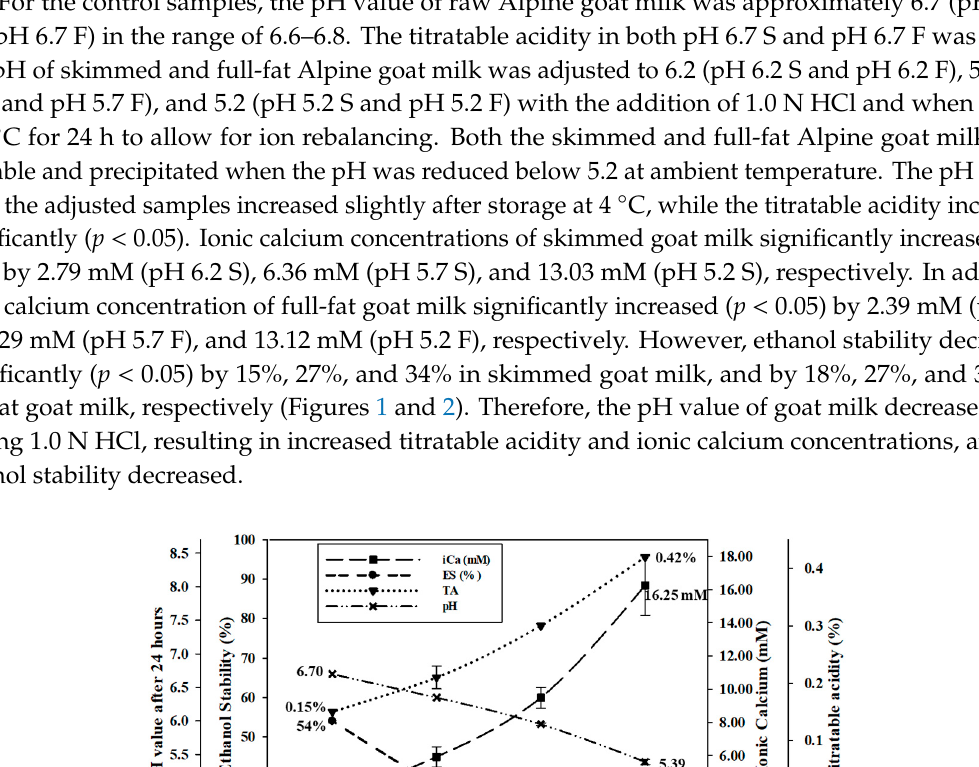
Figure 2. The effect of pH adjustment of full-fat Alpine goat milk on pH value after 24 h, titratable acidity (TA), ionic calcium concentration (iCa), and ethanol stability (ES). 3.3. Delta Backscattering Profiles of Full-Fat and Skimmed Alpine Goat Milk at pH 6.7 and pH 5.2 The gross compositions of goat milk are similar to those of cow milk; however, the heat and ethanol stability of goat milk is much lower than that of cow milk, due to its reduced α s1-casein content and consequently higher ionic calcium content in the serum phase [2,7,29]. Lower pH values of skimmed and full-fat goat milk showed lower ethanol stabilities in this study. The ethanol stability test is a practical means of determining the susceptibility of cow milk and goat milk to heat coagulation [2]. However, the ethanol stability results did not result in milk instability during the heat treatments. In this study, the skimmed and full-fat goat milk with different pH values were scanned every 5 min at 60 °C for 1 h to obtain the ∆ BS profiles. Changes in the ∆ BS profiles indicate sedimentation, coagulation, clarification, or creaming phenomena related to the unstable properties of goat milk samples during scanning; furthermore, the ∆ BS profiles were calculated into the TSI values for statistical analysis. ∆ BS increases of 5%, 3%, and 18% are, respectively, found at the bottom (height at 0–10 mm), middle (height at 10–30 mm), and top (height at 30–42 mm) parts of pH 6.7 S at 60 °C, when scanned for 1 h, indicating that pH 6.7 S has slight coagulation at the bottom and middle parts but creaming at the top part. ∆ BS increased by 24%, 21%, and 25%, respectively, at the bottom, middle, and top parts of pH 5.2 S, indicating that adjusting the pH value of skimmed goat milk to 5.2 resulted in significant coagulation (Figure 3). The ∆ BS change was more complicated and diverse in full-fat goat milk than in skimmed goat milk due to its higher fat content. ∆ BS decreased by 4% at the bottom part of pH 6.7 F but increased